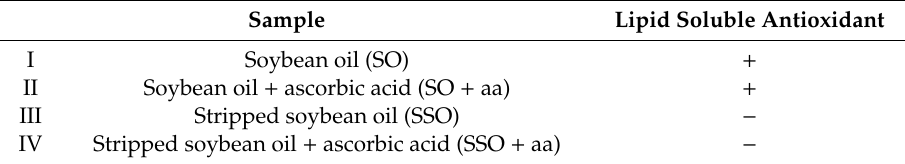
Table 1. The four mayonnaises studied were prepared with soybean oil (SO, Sample I), soybean oil with ascorbic acid (SO + aa, Sample II), stripped soybean oil (SSO, Sample III), stripped soybean oil with ascorbic acid (SSO + aa, Sample